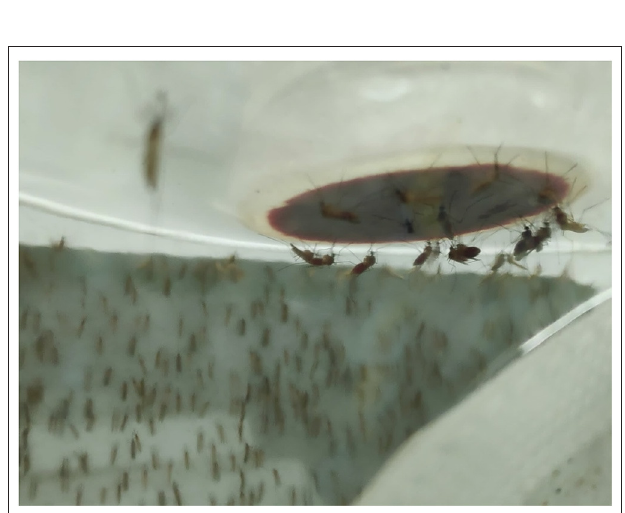
FIGURE 3 | Base of the feeder during experimental